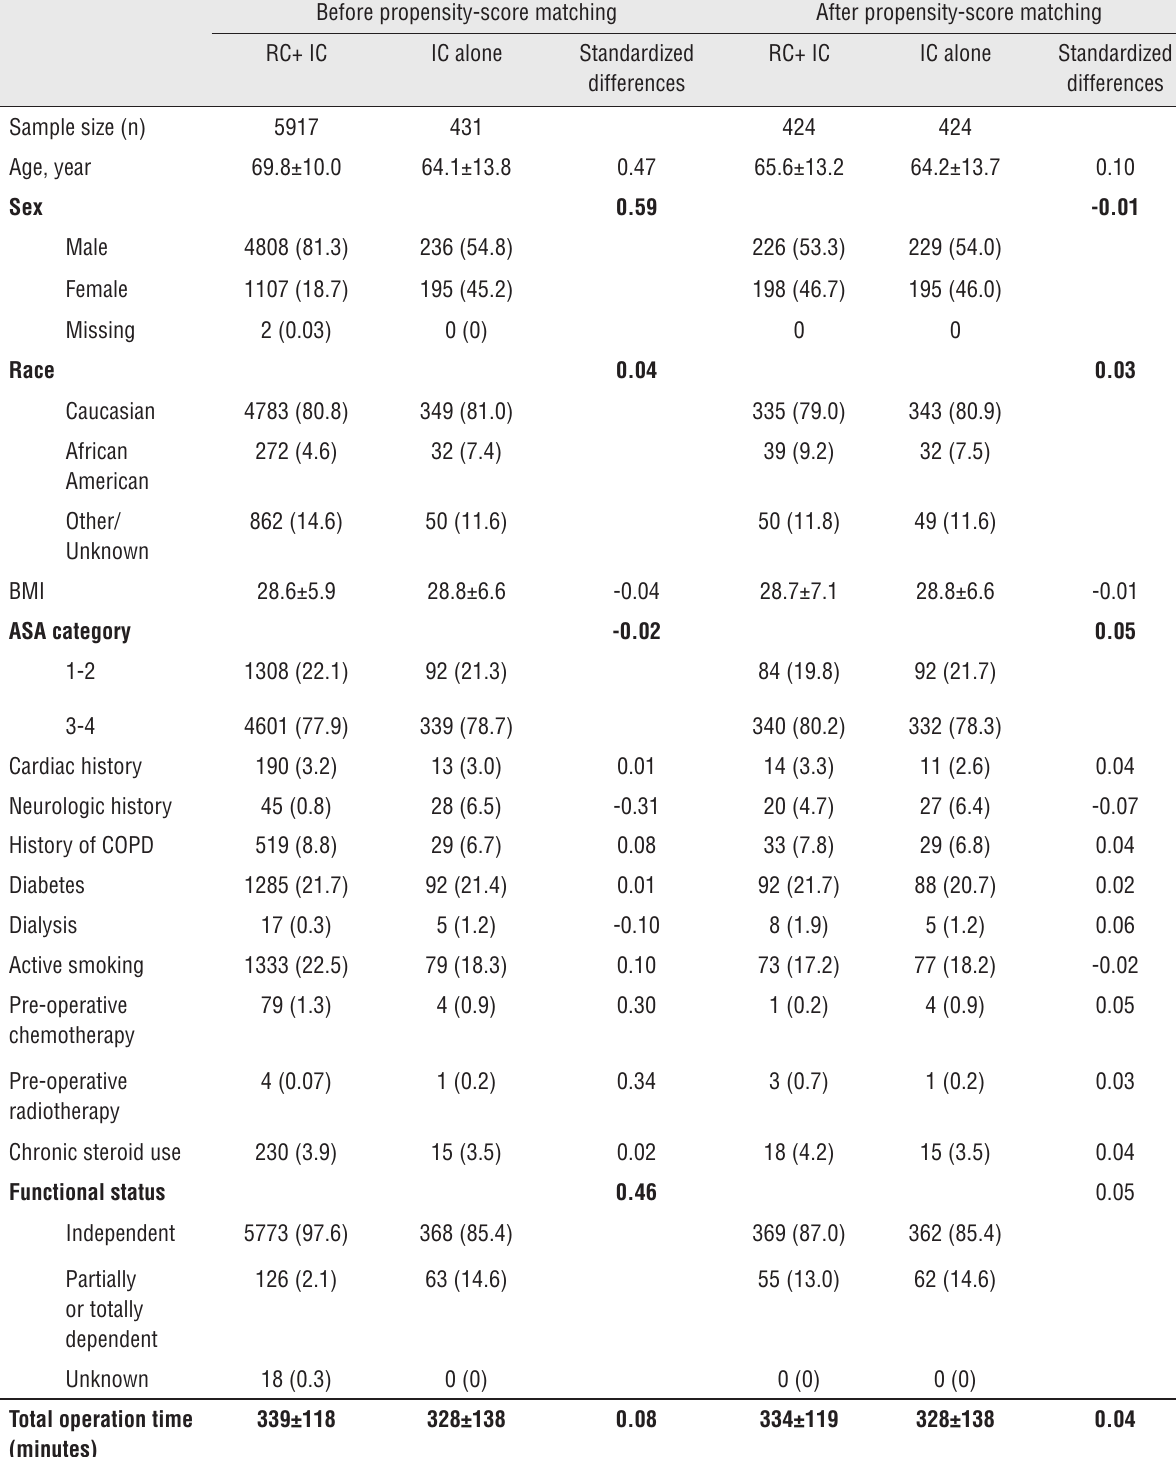
Table 1 - Baseline characteristics of patients before and after propensity-score matching for RC + IC vs IC alone. Before propensity-score matching After propensity-score matching RC+ IC IC alone Standardized RC+ IC IC alone Standardized differences